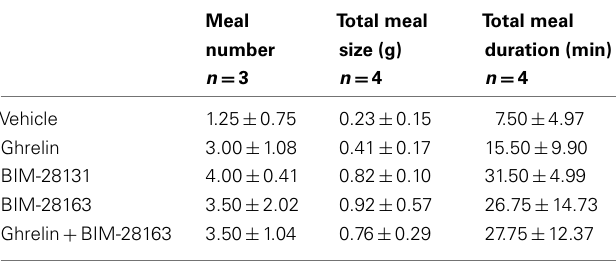
Table 1 | Effect of native ghrelin and BIM compounds on meal pattern measured with the automated feeding station in mice.